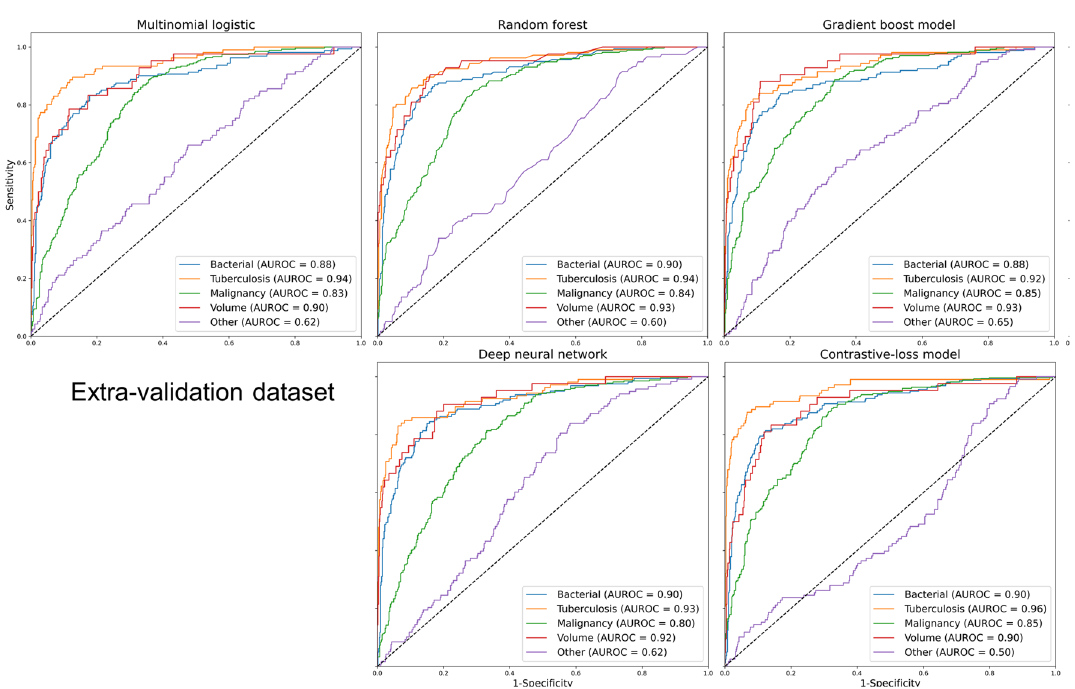
Figure 3. AUROC of each label in the extra-validation dataset. AUROC: area under the receiver operating